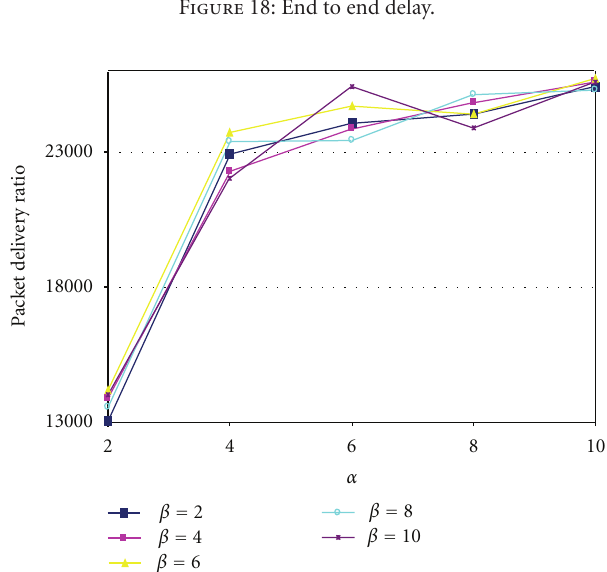
Figure 18: End to end delay.